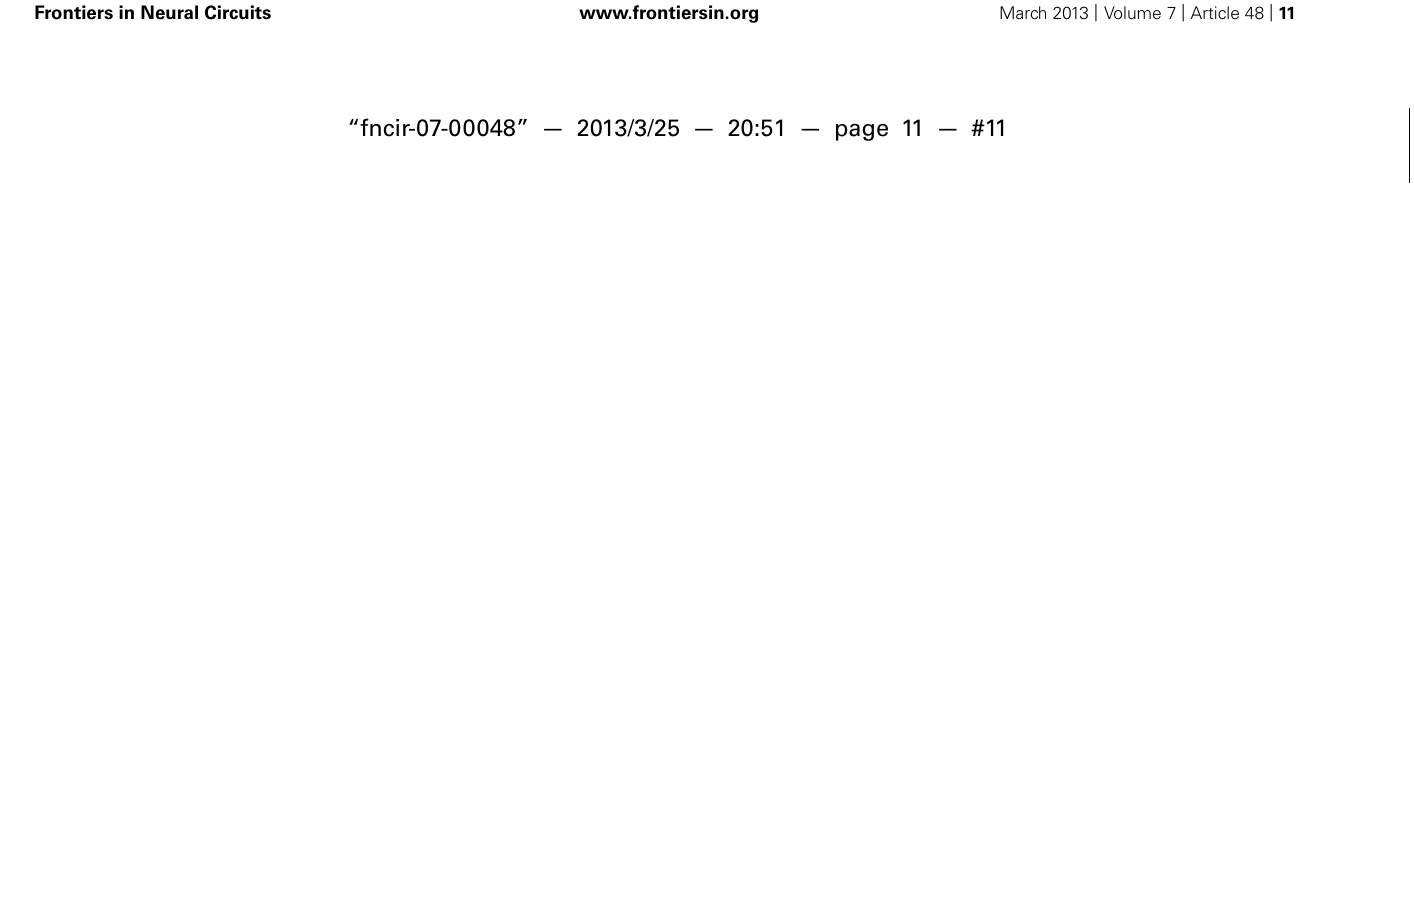
signal (dashed lines). (B–D) Maps of somatosensory properties. Color code indicates min (blue) to max (red) activation, averaged across all neurons recorded during 3 days on each electrode of the array.White squares correspond to the inactive electrodes of the array. la, lateral; me, medial; ro, rostral; ca, caudal; see Figure 1C